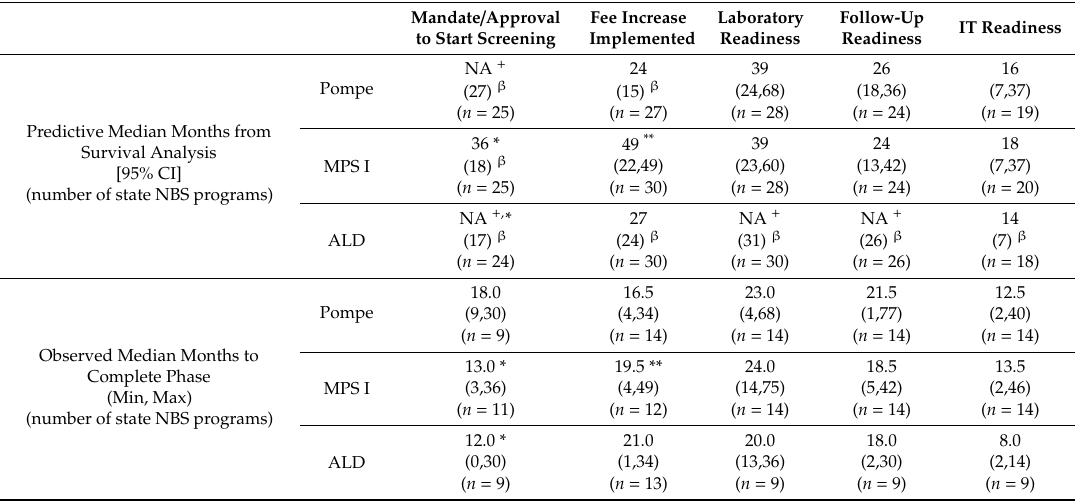
Table 3. ComparisonofObservedMedianTimeandPredictedMedianTimeEstimatedusingKaplan–Meier Survival Analysis to Complete Each Phase of the Implementation Process for Statewide Newborn Screening for New Disorders, as of August